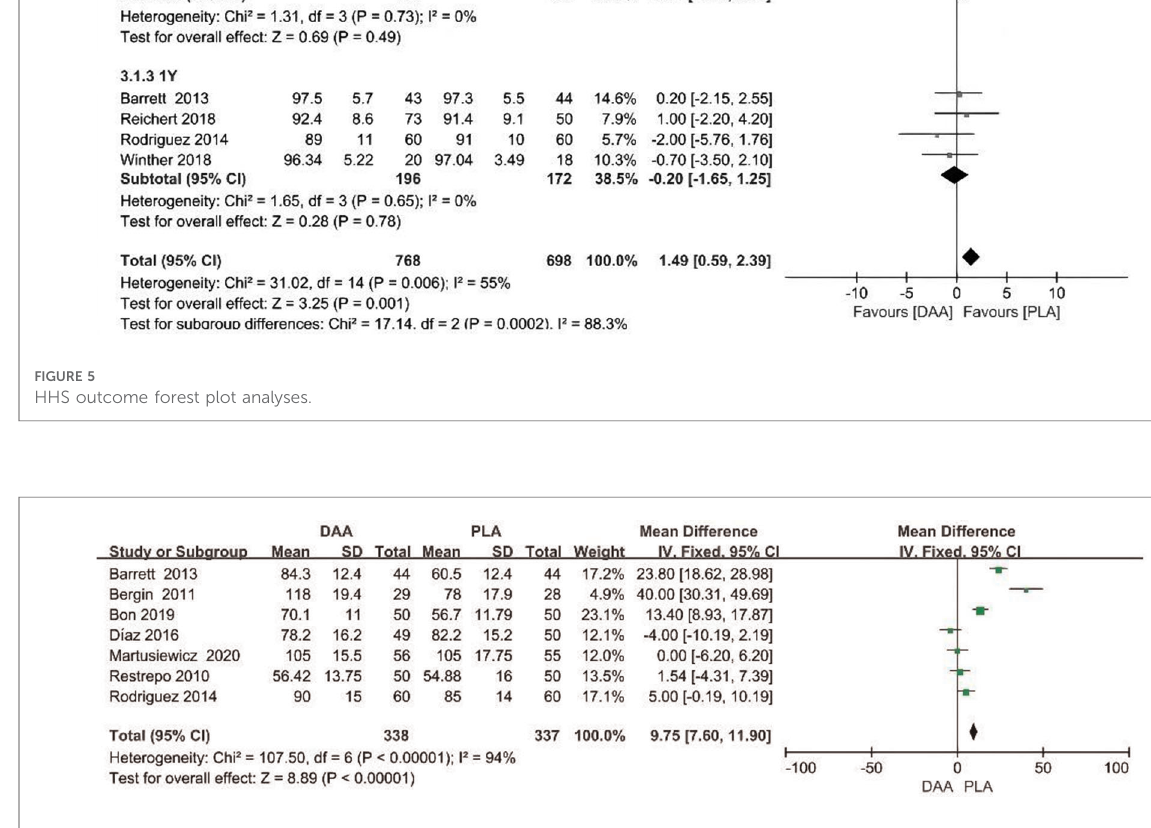
FIGURE 6 Surgery time outcome forest plot